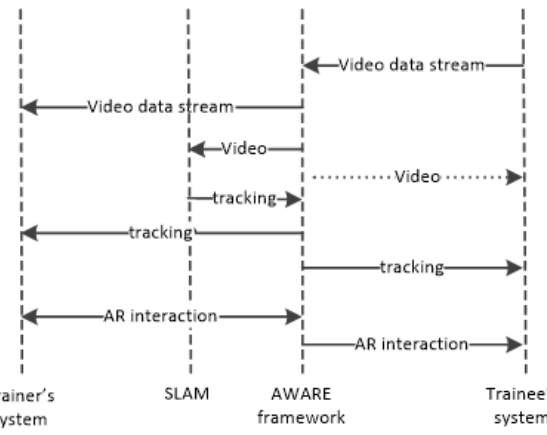
Figure 7. Diagram of data and event